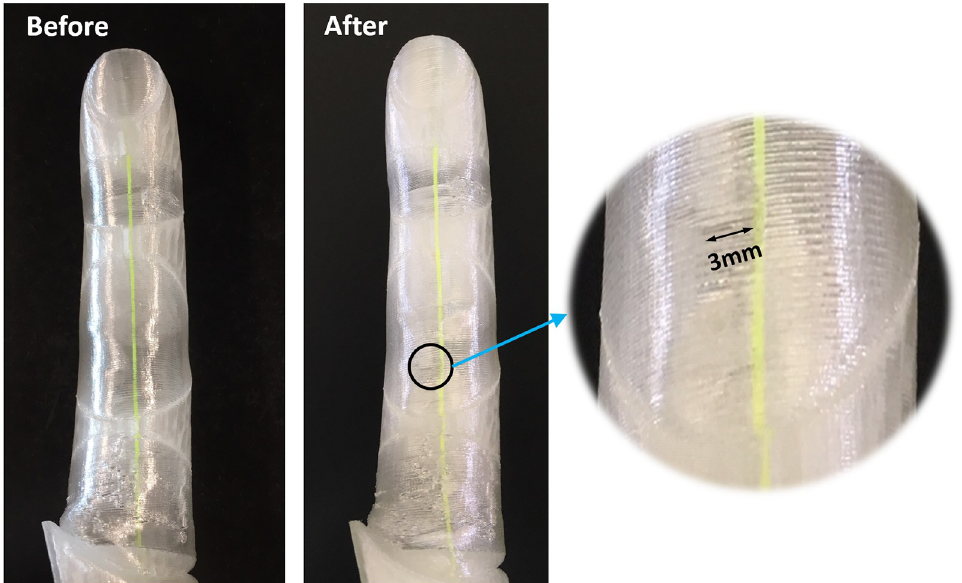
Fig 16. The test finger appearance before and after 45,000 cycle of flexion and extension of the